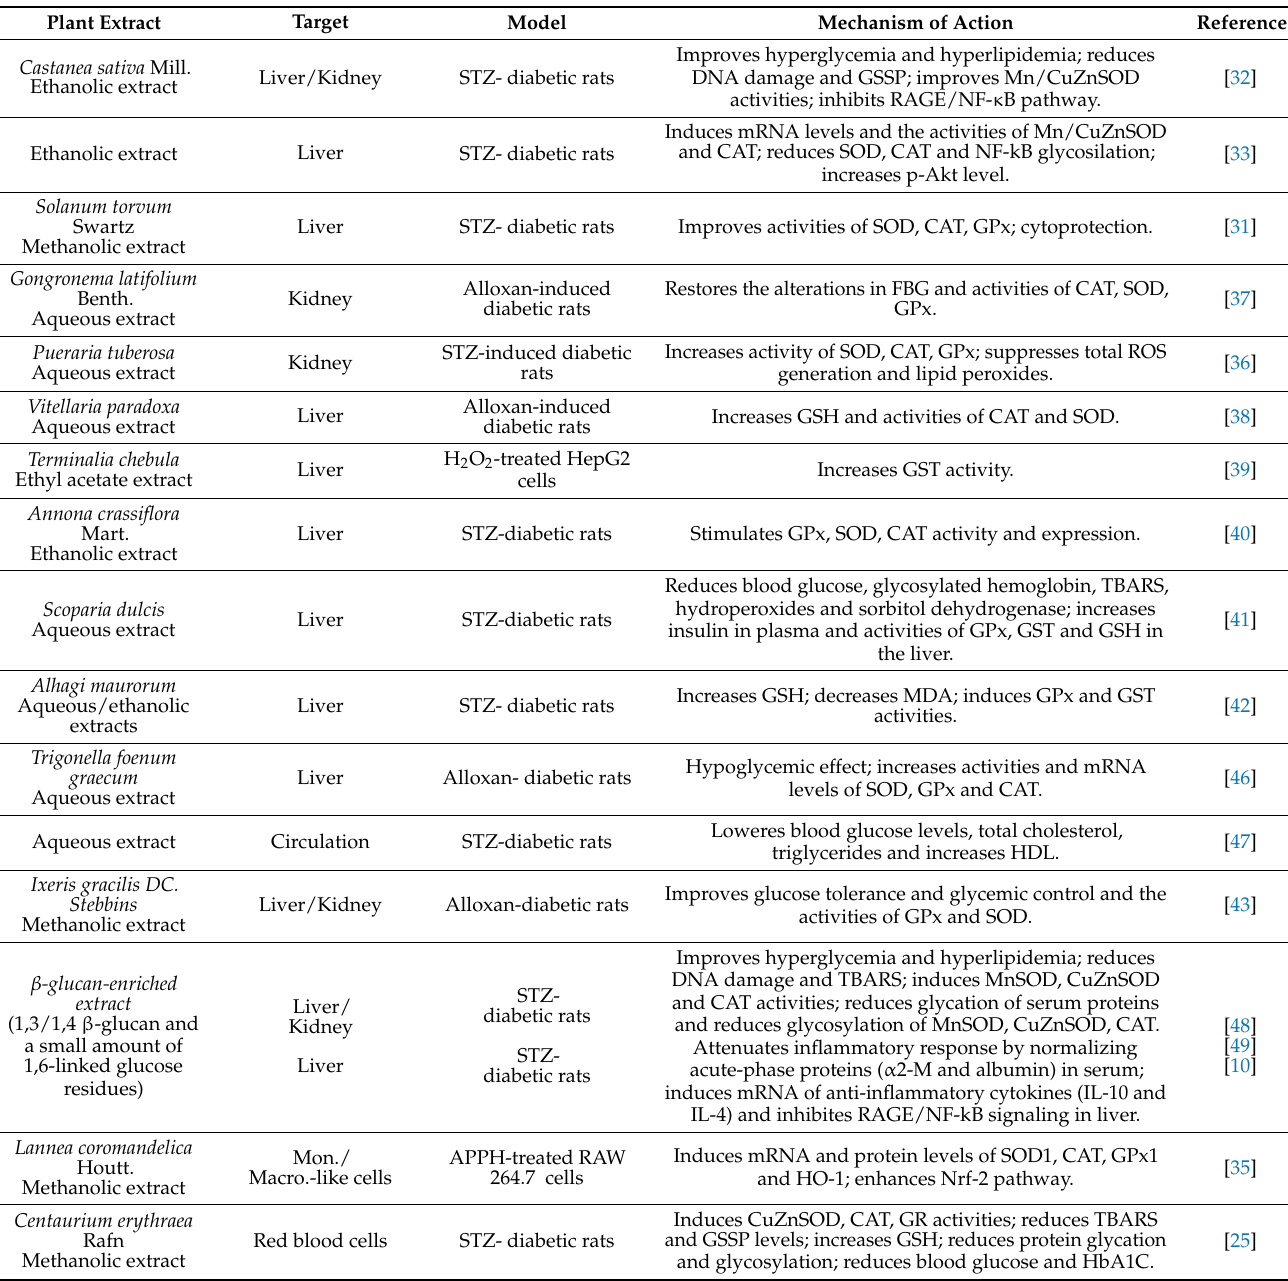
Table 2. Protective effects of plant extracts on liver, kidney, and circulation in diabetic